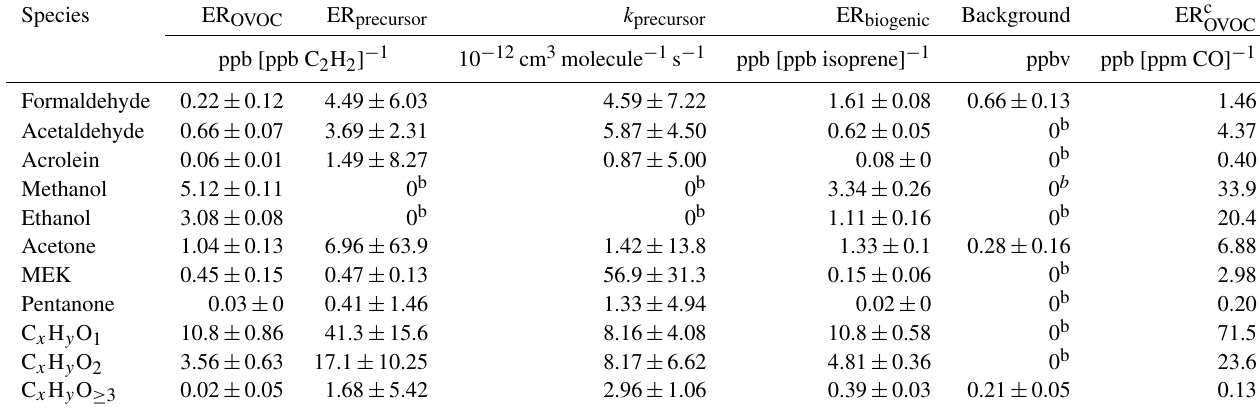
Table 2. Parameters describing OVOC concentrations. Note: parts per billion by volume – ppbv.